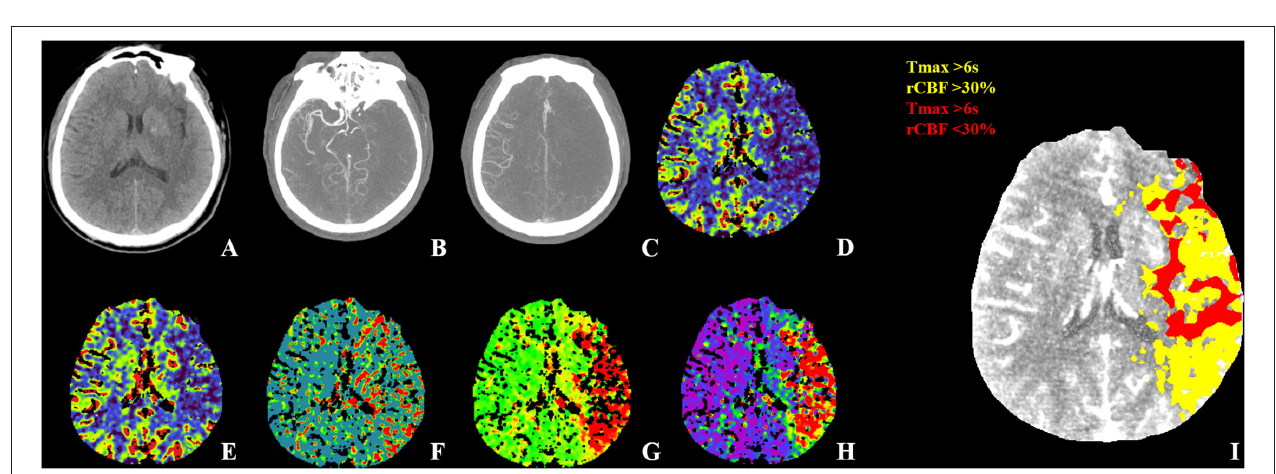
FIGURE 2 | WUS with poor outcome. Fifty-seven-year-old male patient WUS patient last seen well 6.7h before imaging. (A) The NECT show hypodensity in left the insular, lenticular nucleus, M1 and M2 with ASPECTS 6. (B) The CTA-MIP showed left ICA, M1 and M2 occlusion with CBS 0. (C) CTA-MIP showed collateral filling nearly 0% of the MCA flow territory with collateral score one. The CTP showed (D) a large area with decreased CBF, (E) CBV and (F–H) a large area with increased MTT, TTP, and Tmax. The CTP summary map (I) showed 93.73ml of Tmax > 6s (yellow) and 59.08ml of < 30% rCBF decrease (red). The patient was treated EVT (mTICI 2b) and showed poor recovery with a 90-day mRS of six. WUS, wake-up stroke; ASPECTS, Alberta Stroke Program Early CT Score; MIP, maximum intensity projection; CBS, clot burden score; MCA, middle cerebral artery; EVT, endovascular thrombectomy; mTICI, modified Thrombolysis In Cerebral Infarction; mRS, modified Rankin